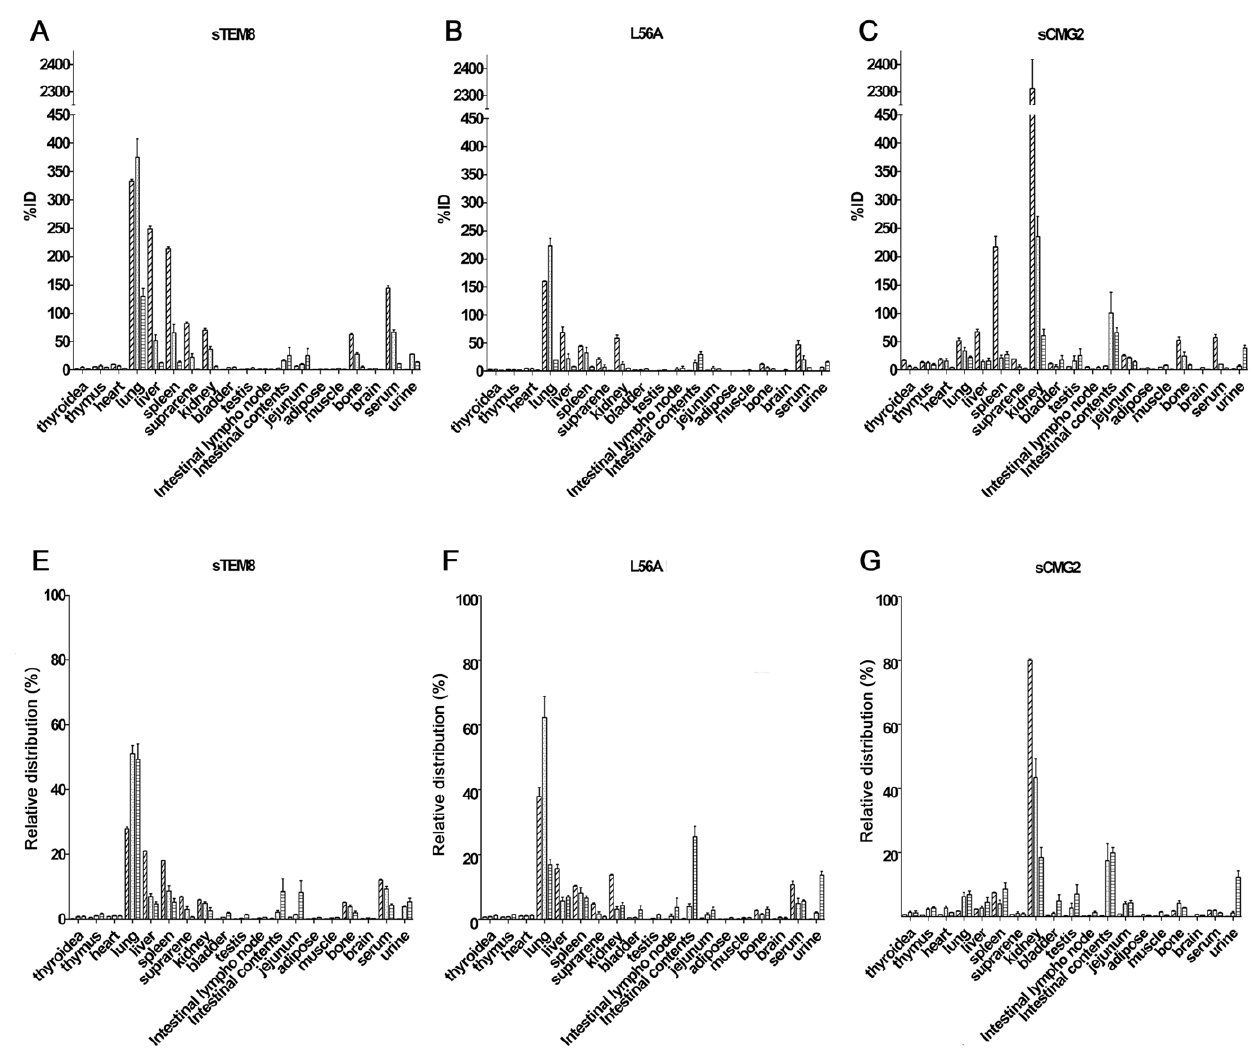
Figure 5. Tissue distribution of the variants. TCA-precipitable radioactivity (mean 6 SEM) in various tissues determined at 5 min, 30 min, and 4 h (n=6) after i.v. administration to rats. A, B, and C . %ID represents the equivalent drug concentrations calculated according to the radioactivity measured as a percentage of the deduced injection dose (67.5 ug/kg). D, E, and F . Relative distribution represents the drug concentration in a certain tissue as a percentage of the total drug concentration in all the